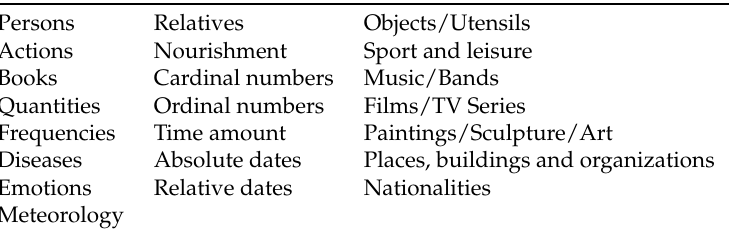
Table 1. List of Entity categories.